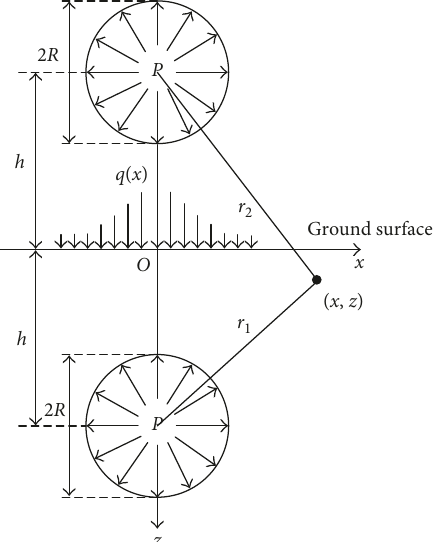
Figure 3: Modified positive stresses on the ground of cylindrical cavity